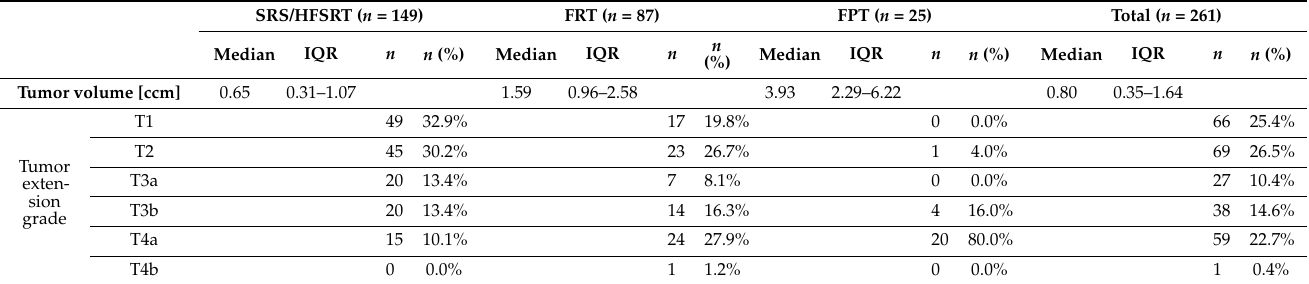
Table 2. Differences in tumor volume and tumor extension grade.